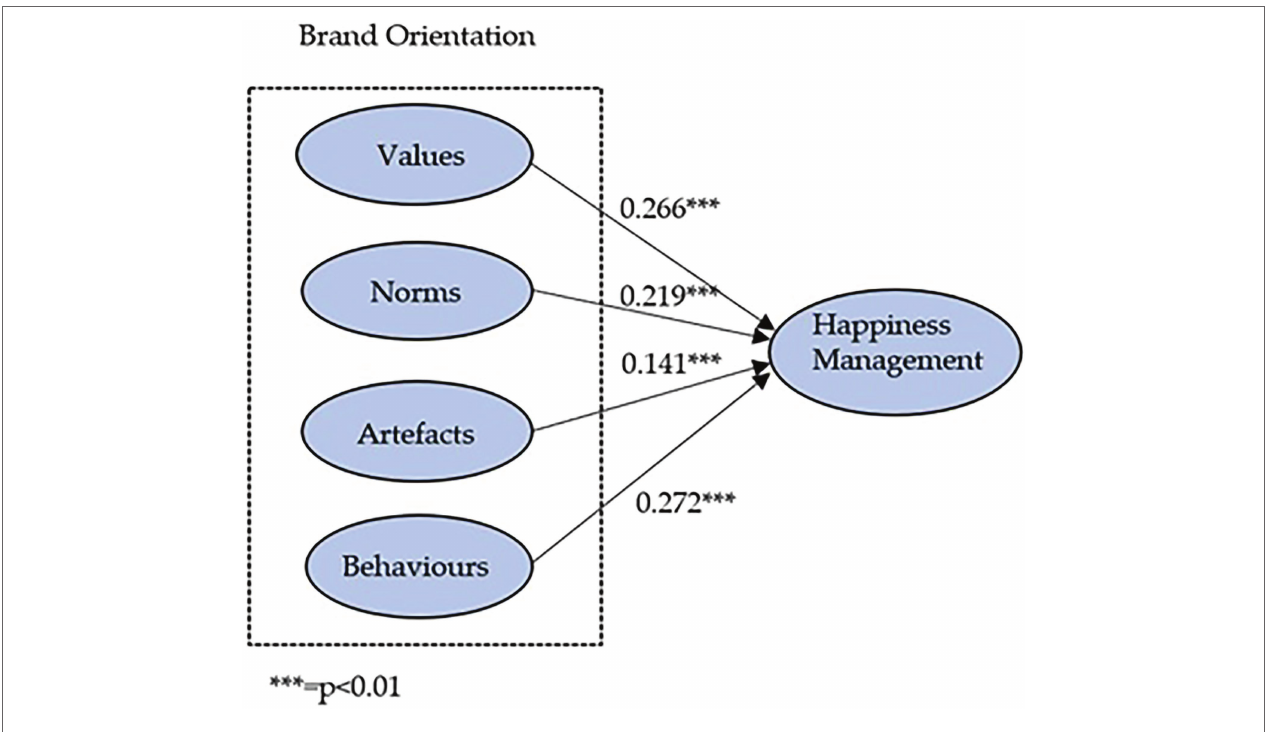
FIGURE 2 | Graphical representation of the structural equation